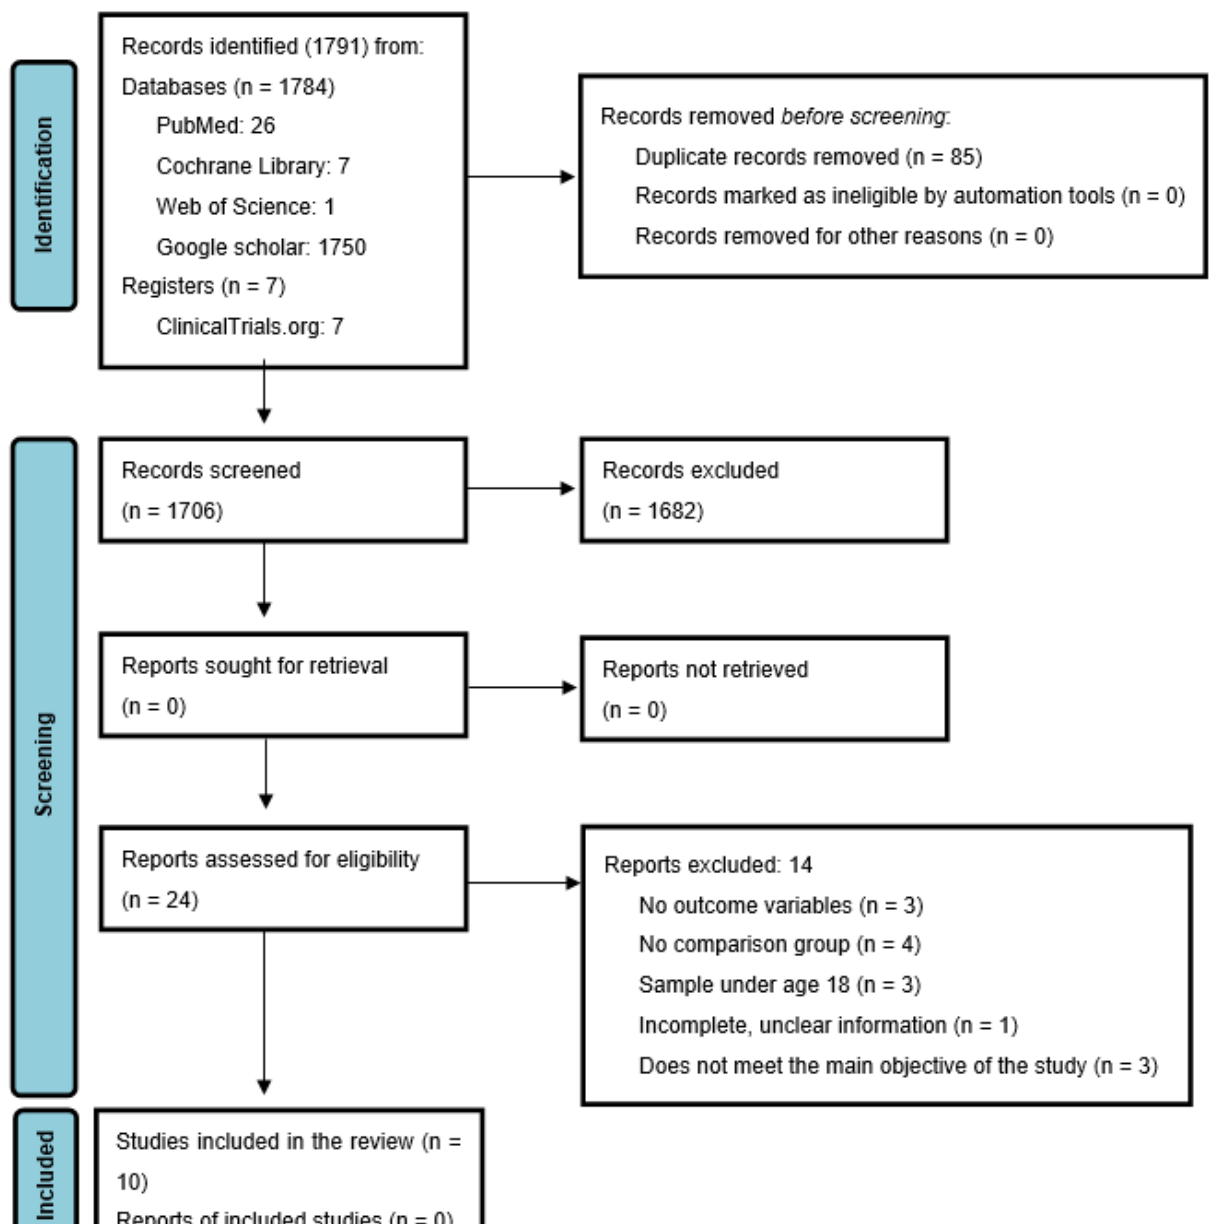
Figure 1. Flow chart of studies included [25].